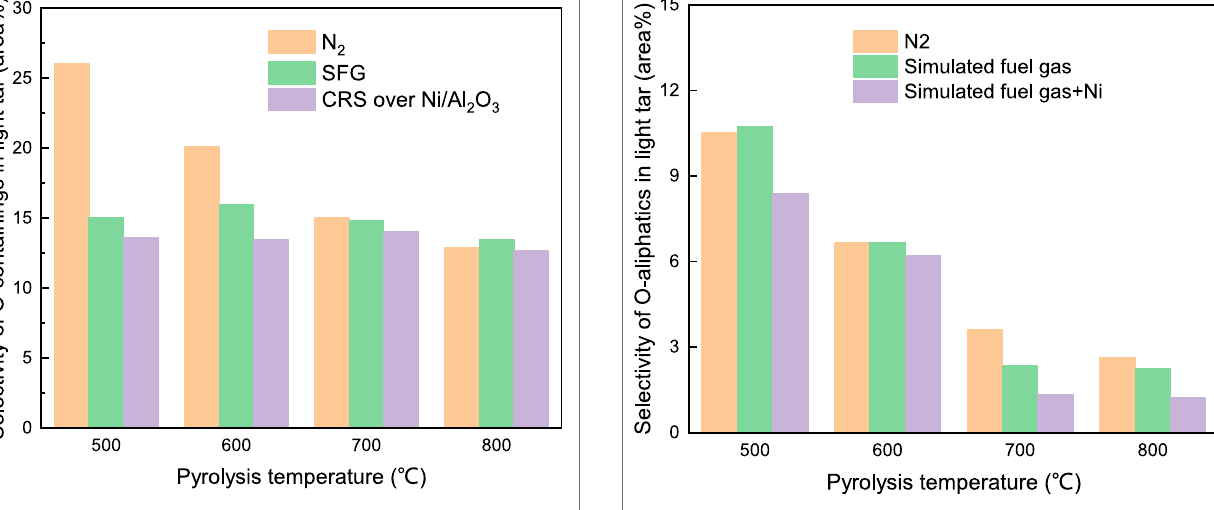
FIGURE 12 | The selectivity of the O-aliphatic components under different atmosphere.